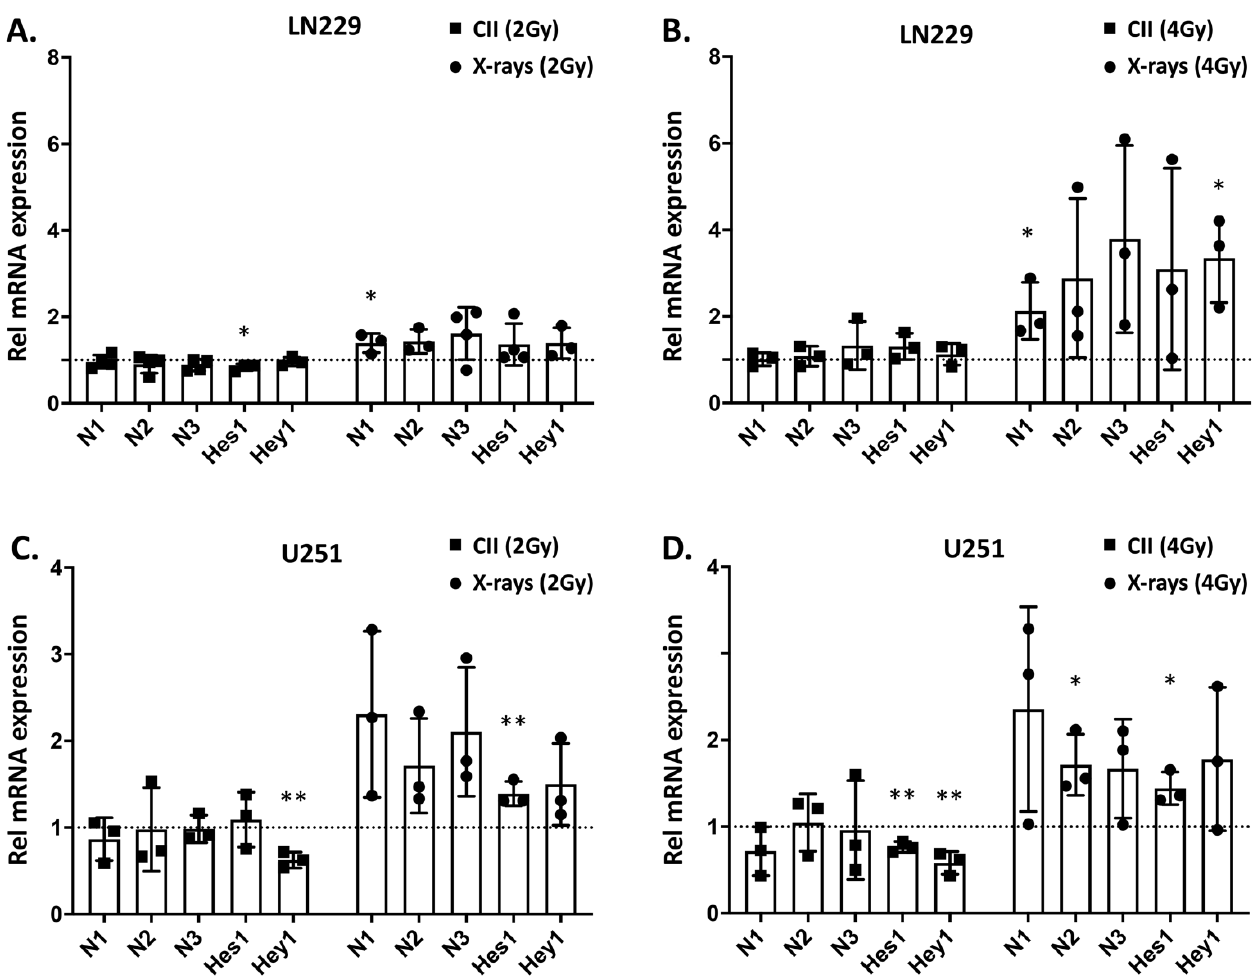
Figure 1. Differential regulation of Notch signaling genes by CII and X-rays in human glioma cell lines: The mRNA expression of Notch receptors (relative to un-irradiated sample): Notch1 (N1), Notch2 (N2), and Notch3 (N3); Notch target genes: Hes1 and Hey1 , observed at 24 h after irradiation were analyzed by qRT-PCR in LN229 and U251 monolayer cell culture irradiated with either ( A , C ) 2 Gy X-ray or carbon ion irradiation or; ( B , D ) 4 Gy X-ray or carbon ion irradiation. Each symbol represents an independent experiment performed in triplicate. Data are presented as mean ± SD. p values were determined by an unpaired two-tailed Student’s t -test, * p < 0.05, ** p < 0.01.